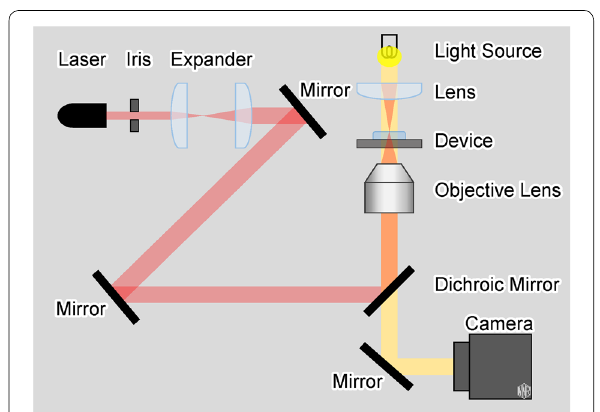
Fig. 3 Experimental system